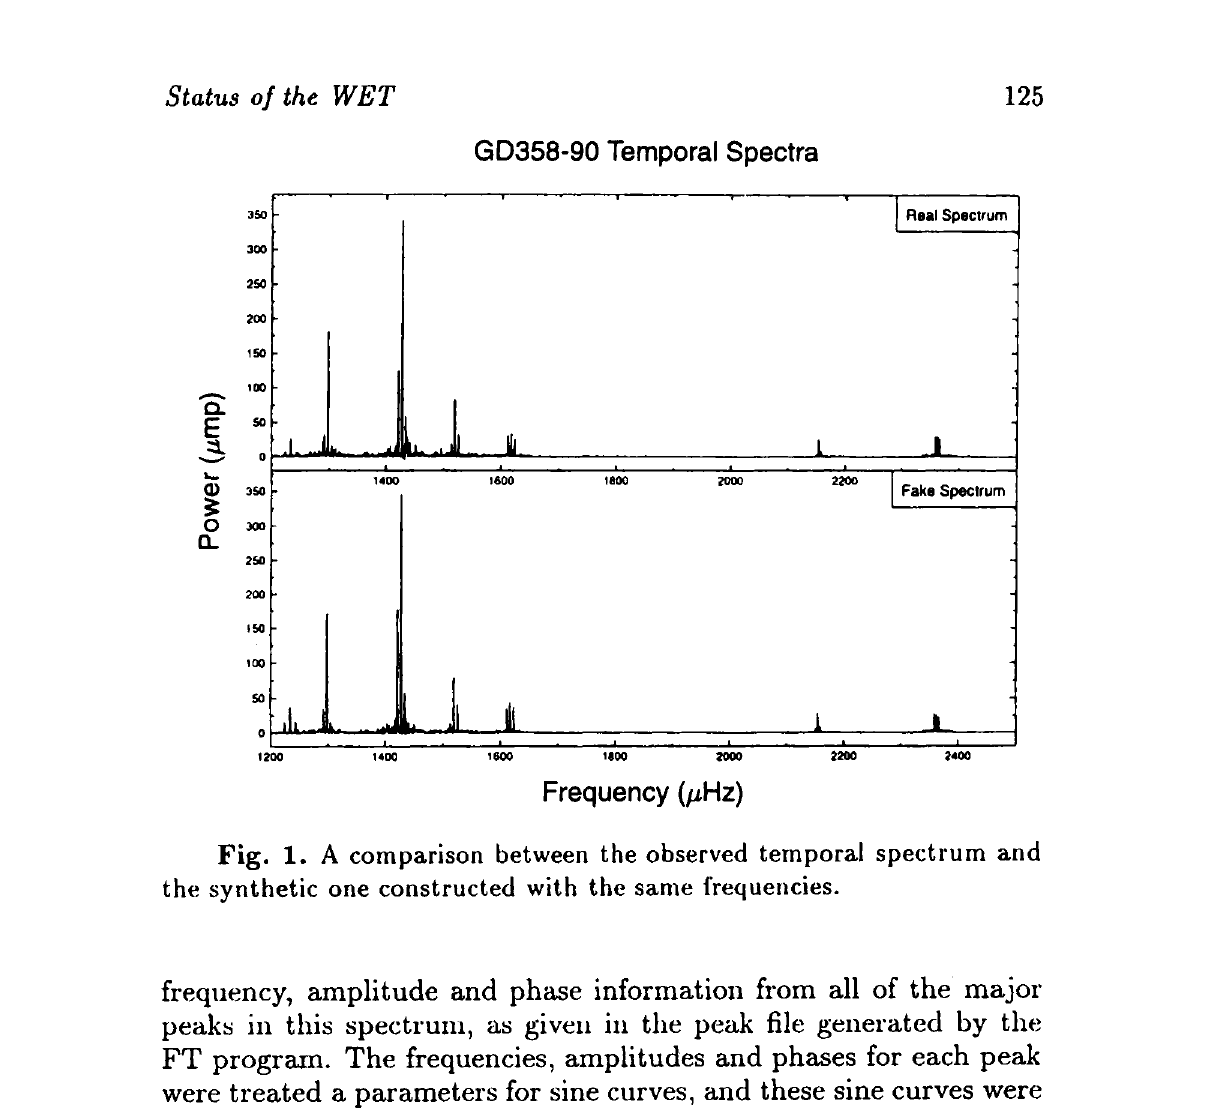
Fig. 1. A comparison between the observed temporal spectrum and the synthetic one constructed with the same